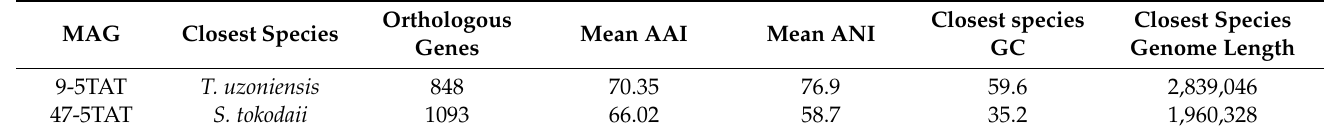
Table 2. Average nucleotide identity (ANI) and Average amino acid identities (AAI) for MAGs. Orthologous MAG Closest Species